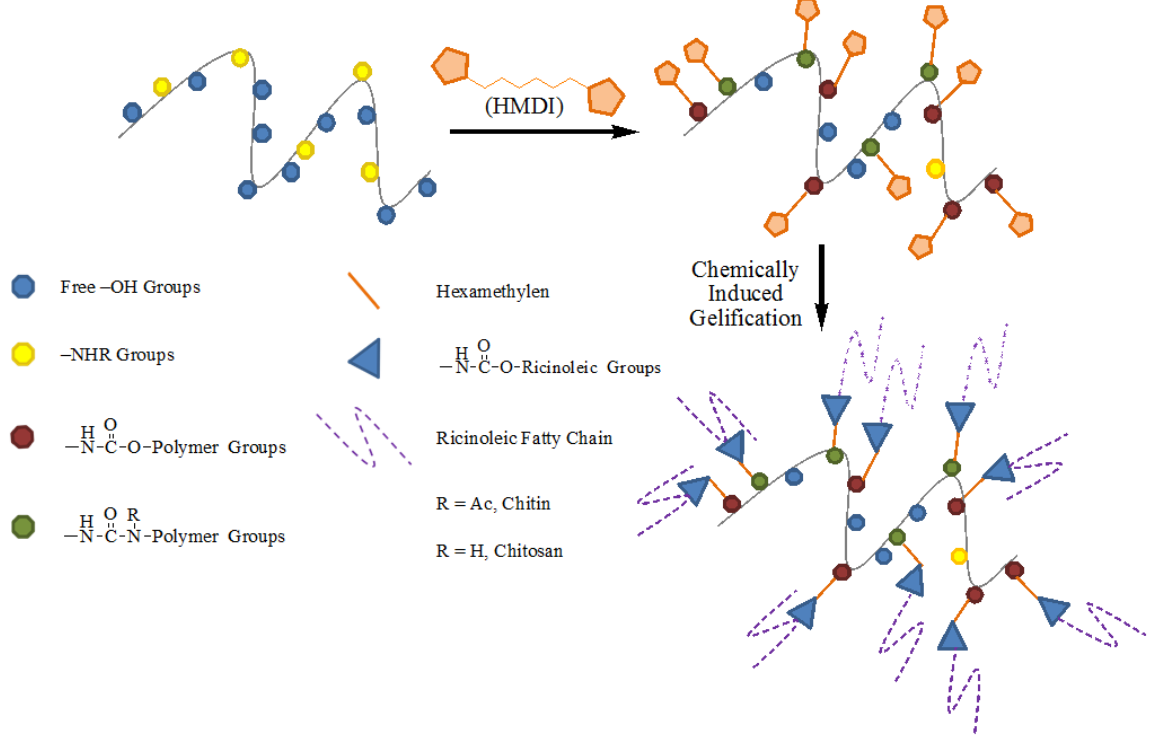
Figure 1. General strategy for chitin and chitosan NCO–functionalization and reaction with ricinoleic fatty acid during oleogel